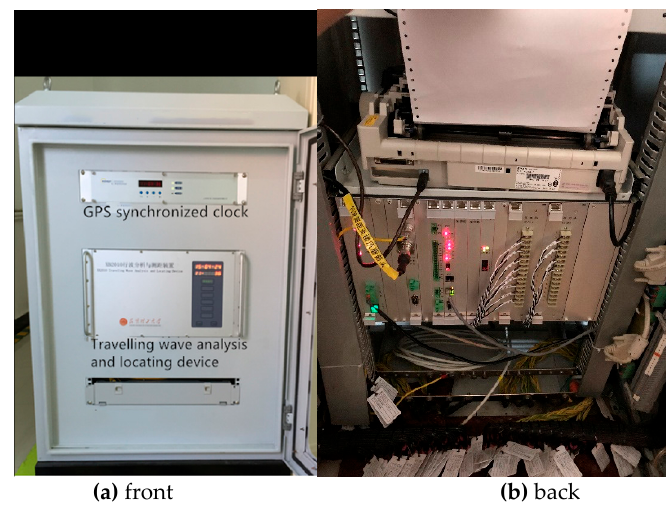
Figure 15. Travelling wave analysis and locating device.